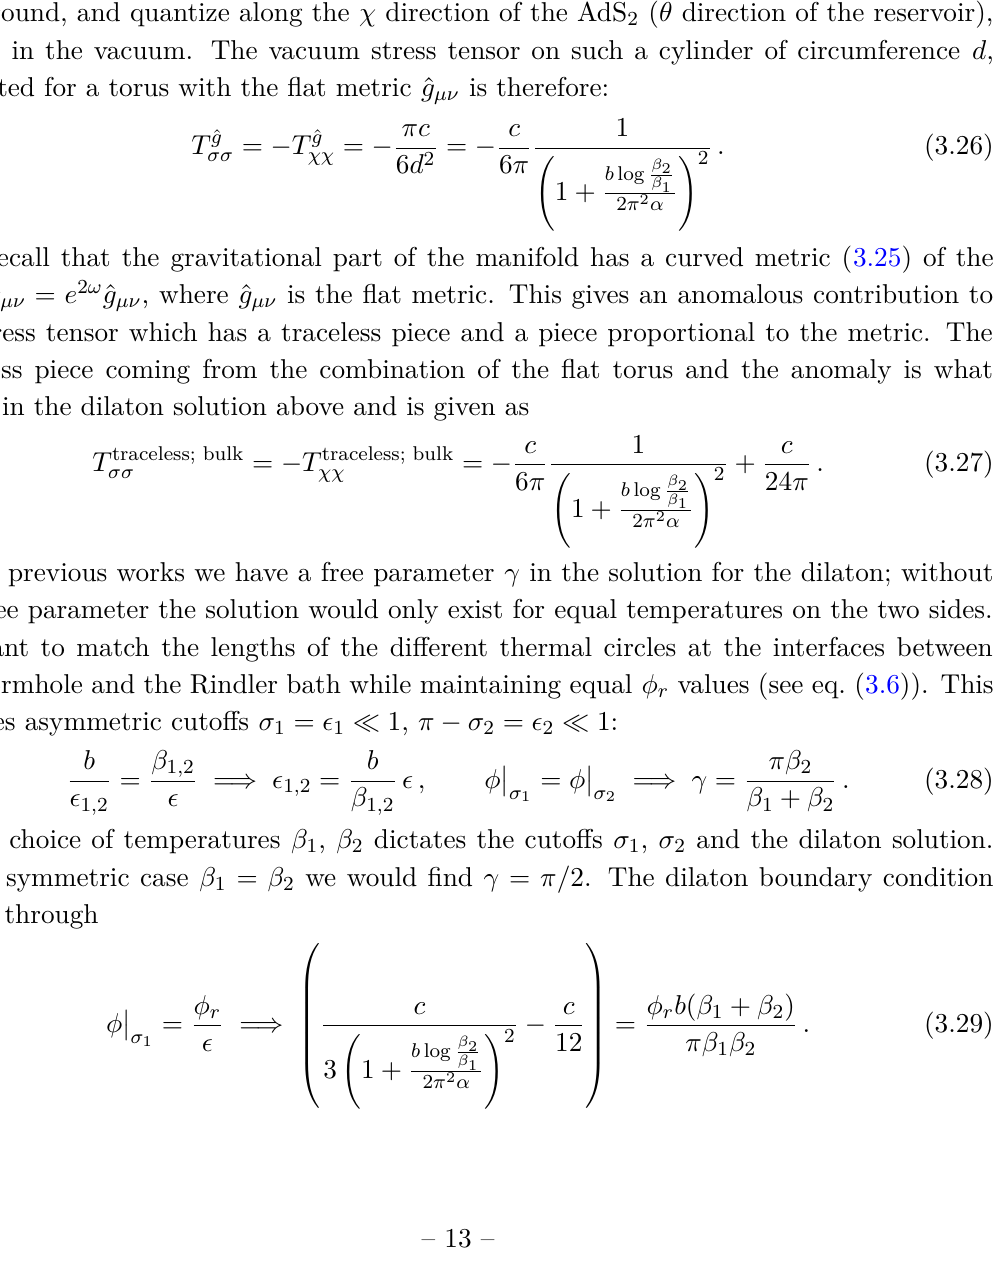
boundaries. Correspond- 2